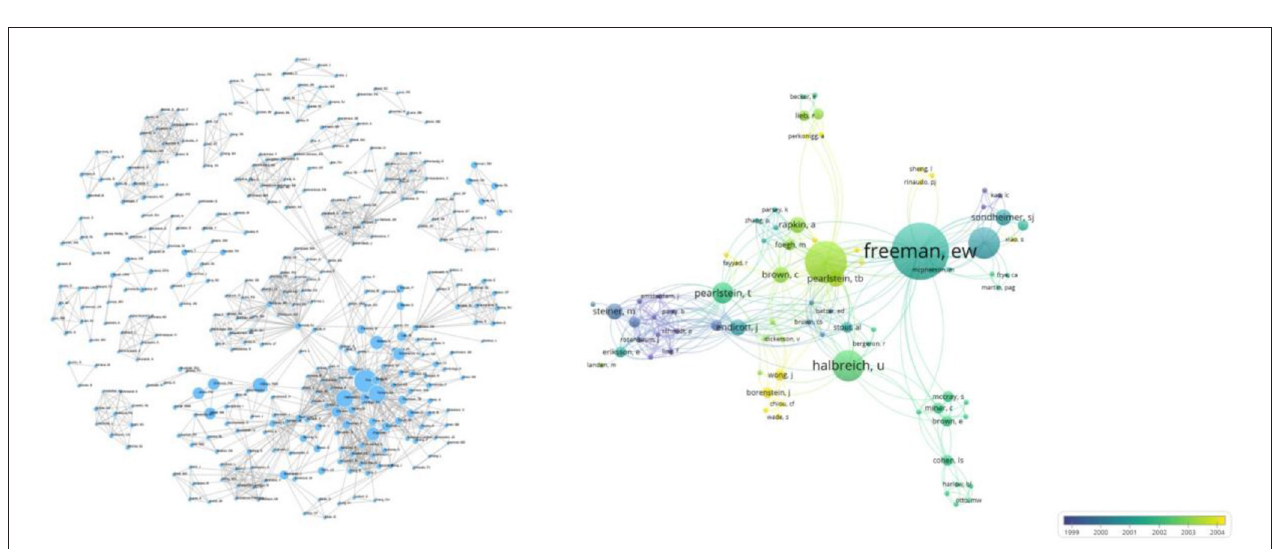
FIGURE 3 | Network-based visualization of journals that published the 100 most cited articles according to average publication year. The size of the circles represents the number of articles in the 100 most cited list, whereas the width of the curved line denotes link strength. The distance between 2 journals indicates the approximate relatedness of the nodes.